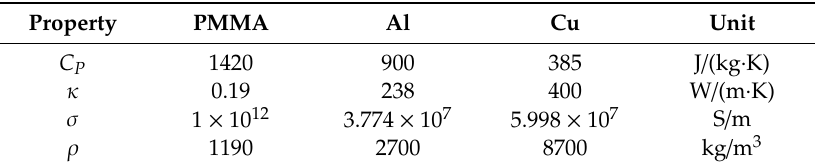
Table 1. Required parameters for modeling of solid